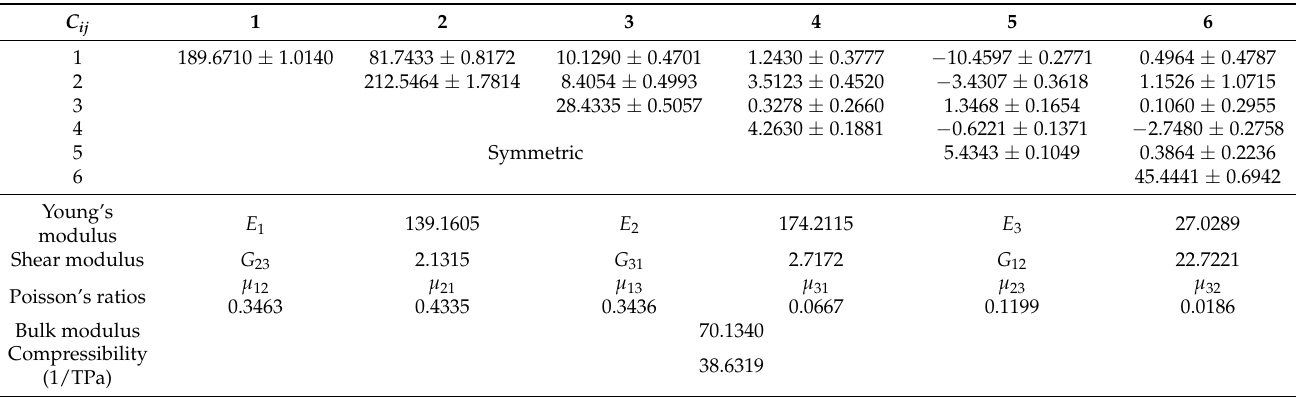
Table 1. Typical stiffness coefficients and elastic constants of hydrated Ca-MM